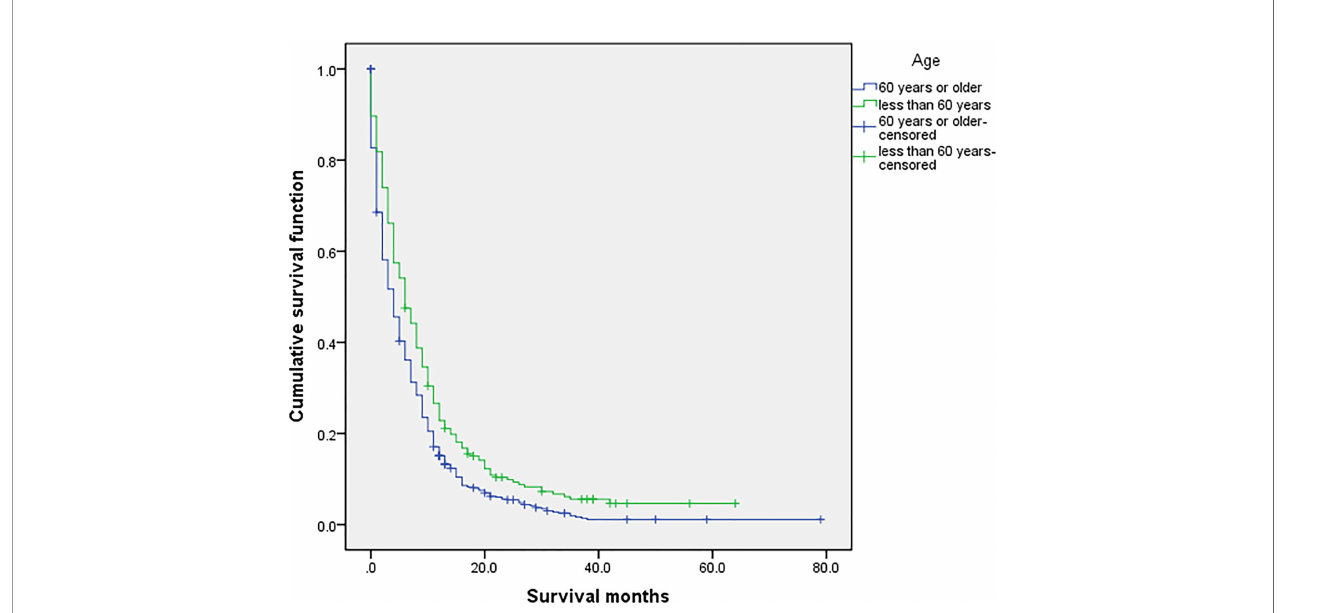
FIGURE 2 | Univariate analysis of 60 years or older and less than 60 years. In the organ metastasis group (n = 870), the univariate analysis of 60 years or older and less than 60 years showed that P < 0.001 was obtained by Kaplan – Meier survival analysis log rank (mental Cox). There was signi fi cant difference between the two